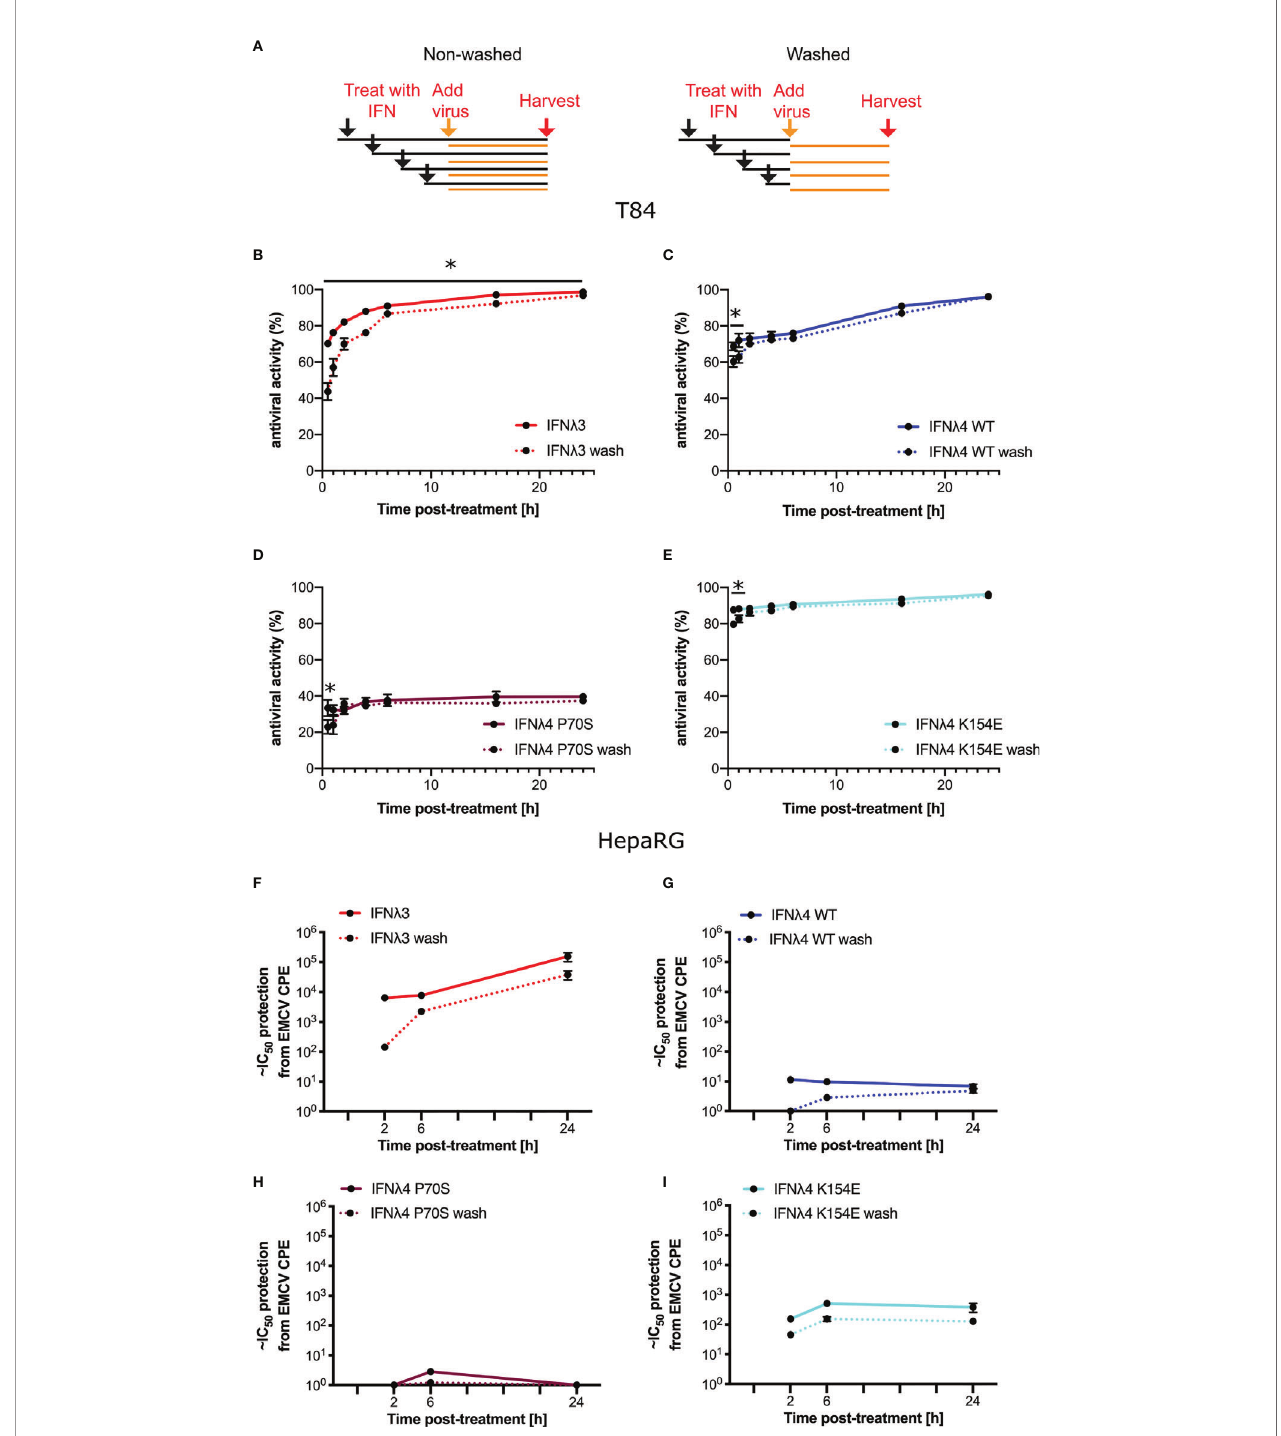
FIGURE 4 | Antiviral activity does not require continued presence of IFN l s. (A) Schematic description of the experiment to show how IFN l was added and maintained or removed by washing. T84 (B – E) and HepaRG (F – I) were stimulated with IFN l s: IFN l 3-HiBiT (B, F) , IFN l 4-HiBiT WT (C, G) , P70S (D, H) , and K154E (E, I) at indicated time prior to infection with EMCV (HepaRG) or VSV (T84). VSV-luc (B – E) was assayed 8 h post-infection by quantifying the luminescence (T84). EMCV infection (F – I) was assayed by analysis of its cytopathic effect 24 h postinfection of a series of twofold serial dilutions of supernatant. For washing experiments (dashed lines), IFN l s were removed and rinsed with PBS before being replaced with media containing virus. Error bars represent the mean ± SEM from two to four biological replicates from one (T84) or two (HepaRG) independent protein batches. Statistical signi fi cance is shown (*p ≤